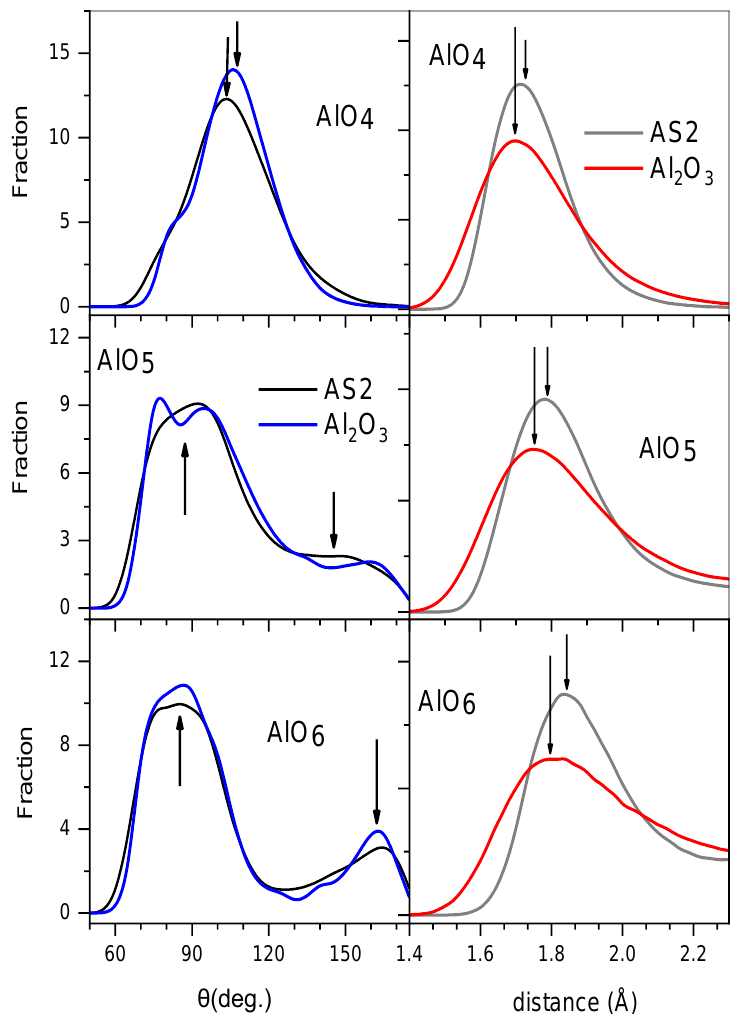
Figure 6. The θ O─Al─O bond angle and Al─O bond distance distribution in AlO 4 , AlO 5 , and AlO 6 units for pure Al 2 O 3 and AS2 glasses. An arrow presents the position of the main peak on curves that shows the difference between an idea and distorted AlO 4 , AlO 5 , and AlO 6